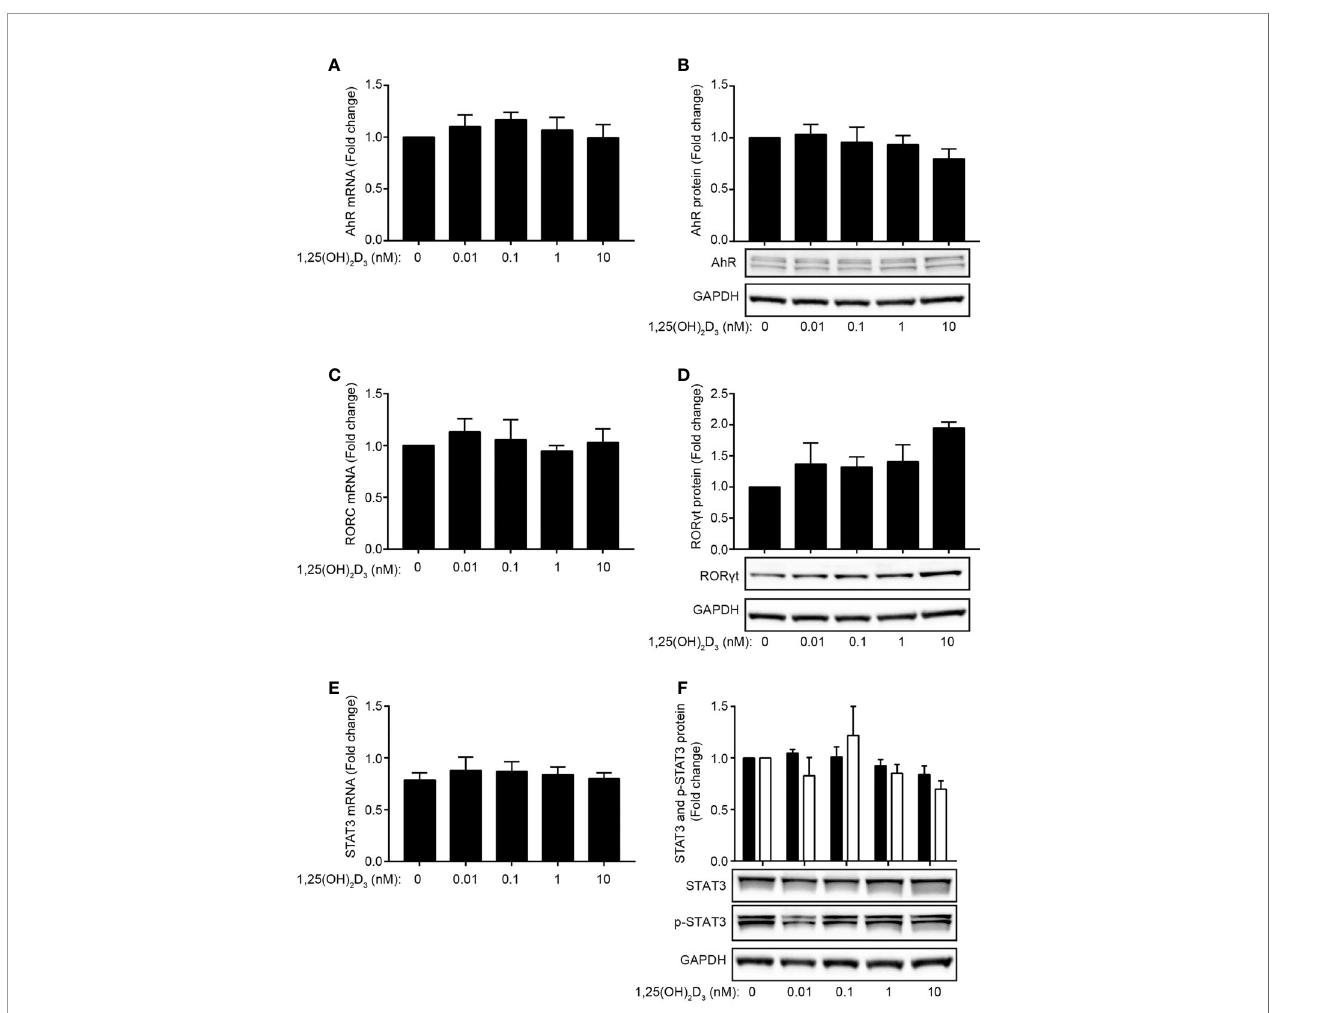
FIGURE 4 | 1,25(OH) 2 D 3 does not inhibit IL-22 by affecting AhR, ROR g t or STAT-3 expression. (A) Relative AhR mRNA expression and (B) representative Western Blot (lower panel) and quanti fi cation (upper panel) of AhR with GAPDH as loading control from naïve CD4 + T cells co-cultured with allogeneic DC for 96 h in Th22 medium and the indicated concentrations of 1,25(OH) 2 D 3 . (C) Relative RORC mRNA expression and (D) representative Western Blot (lower panel) and quanti fi cation (upper panel) of ROR g t with GAPDH as loading control from naïve CD4 + T cells co-cultured with allogeneic DC for 96 h in Th22 medium and the indicated concentrations of 1,25(OH) 2 D 3 . (E) Relative STAT-3 mRNA expression and (F) representative Western Blot (lower panel) and quanti fi cation (upper panel) of STAT-3 and phosphorylated STAT-3 (p-STAT3) with GAPDH as loading control from naïve CD4 + T cells co-cultured with allogeneic DC for 96 h in Th22 medium and the indicated concentrations of 1,25(OH) 2 D 3 . The data are normalized to the values obtained from DC-T cell co-cultures incubated in Th22 medium in the absence of